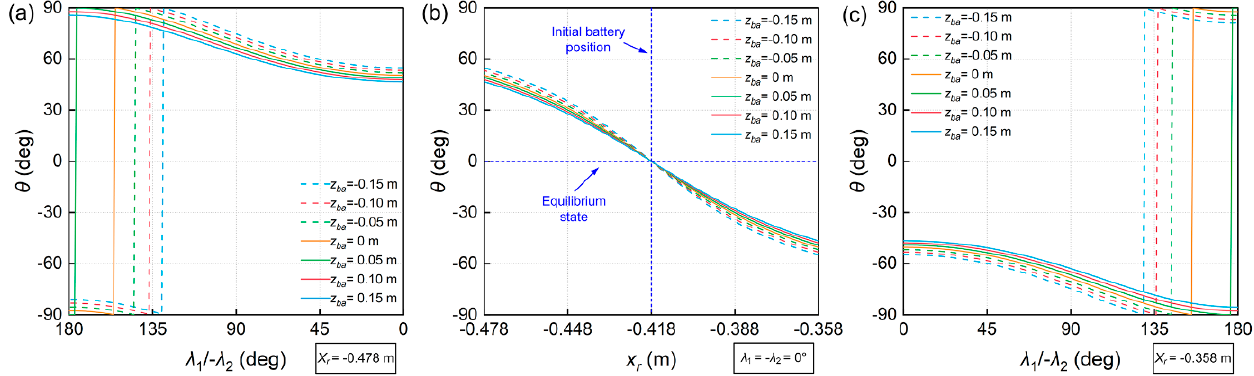
Figure 15. The regulation range of θ for different z ba with m ba equals to 1.0 kg: ( a ) θ vs. λ 1 / − λ 2 ( x r = − 0.478 m); ( b ) θ vs. x r ( λ 1 / − λ 2 = 0°); ( c ) θ vs. λ 1 / − λ 2 ( x r = − 0.358 m).